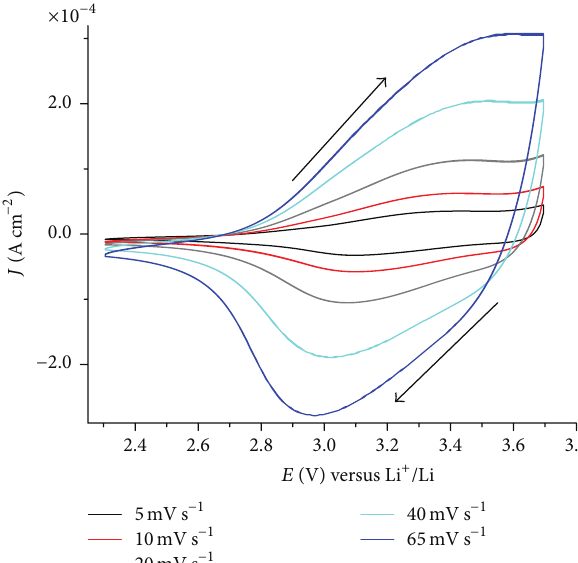
Figure 8: Scan rate dependence of the cyclic voltammograms spray-deposited onto ITO. Cell configuration and of RDS NiO x electrolyte composition as in Figure 1. Prior to these experiments RDS NiO was cycled until the completion of the activation of the oxidation process (see Figure 1). Arrows indicate the verse of potential scan.